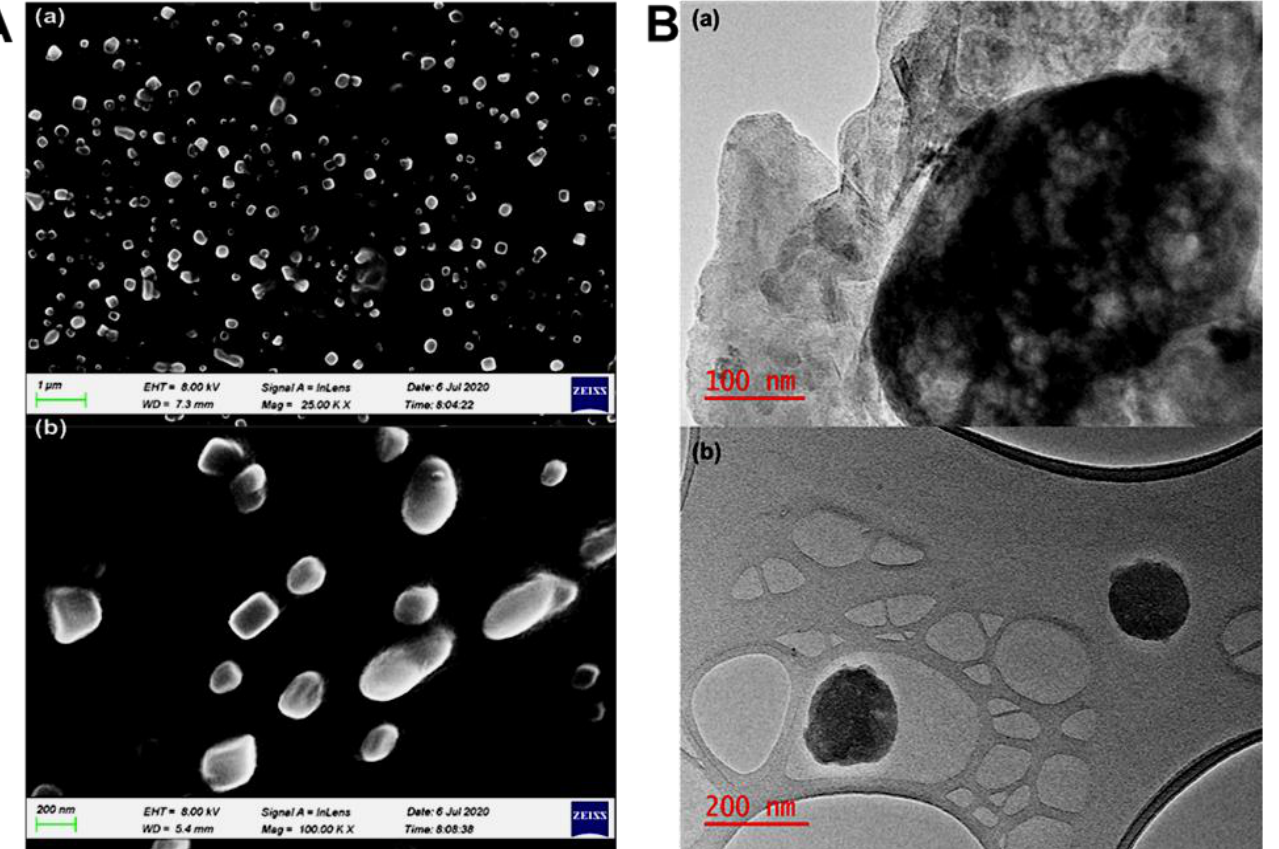
Figure 11. ( A )SEM images of the ( a ) SLNs and ( b ) suspended drug molecules in the lipid matrices of the SLNs; ( B ) Transmission electron microscope (TEM) images of ( a ) SLNs at 100 nm ( b ) at 200 nm.